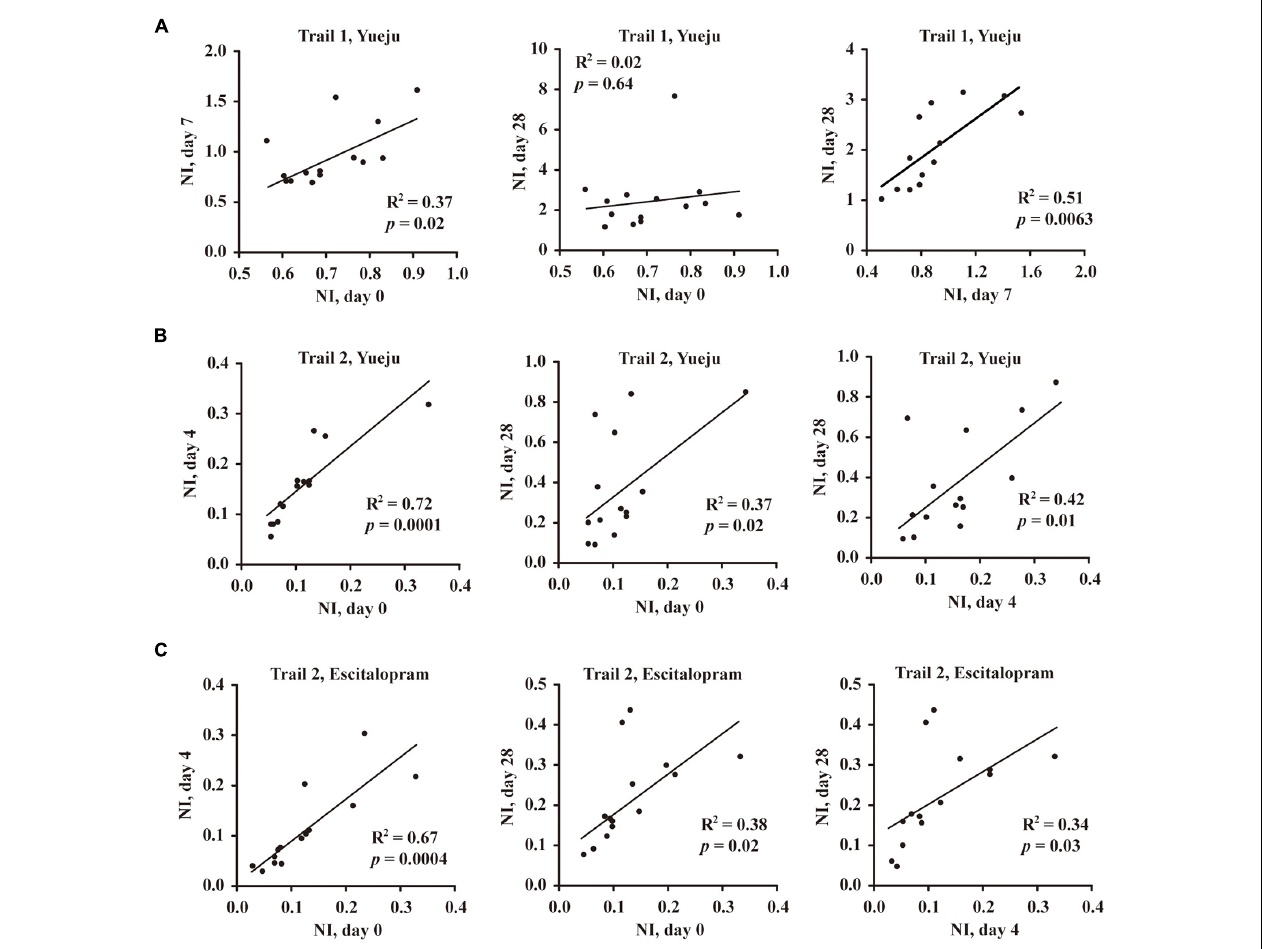
FIGURE 4 | Correlation analysis of neuroplasticity index (NI), the ratio of BDNF to HAMD-24 score in Trial 1 and Trial 2. (A) Correlation of NI between baseline (Day 0, D0), early treatment time (D7), and final treatment time (D28) after Yueju pill treatment in Trial 1. (B) Correlation of NI between baseline (D0), early treatment time (D4), and final treatment time (D28) after Yueju pill treatment in Trial 2. (C) Correlation of NI between baseline (D0), early treatment time (D4), and final treatment time (D28) after escitalopram treatment in Trial